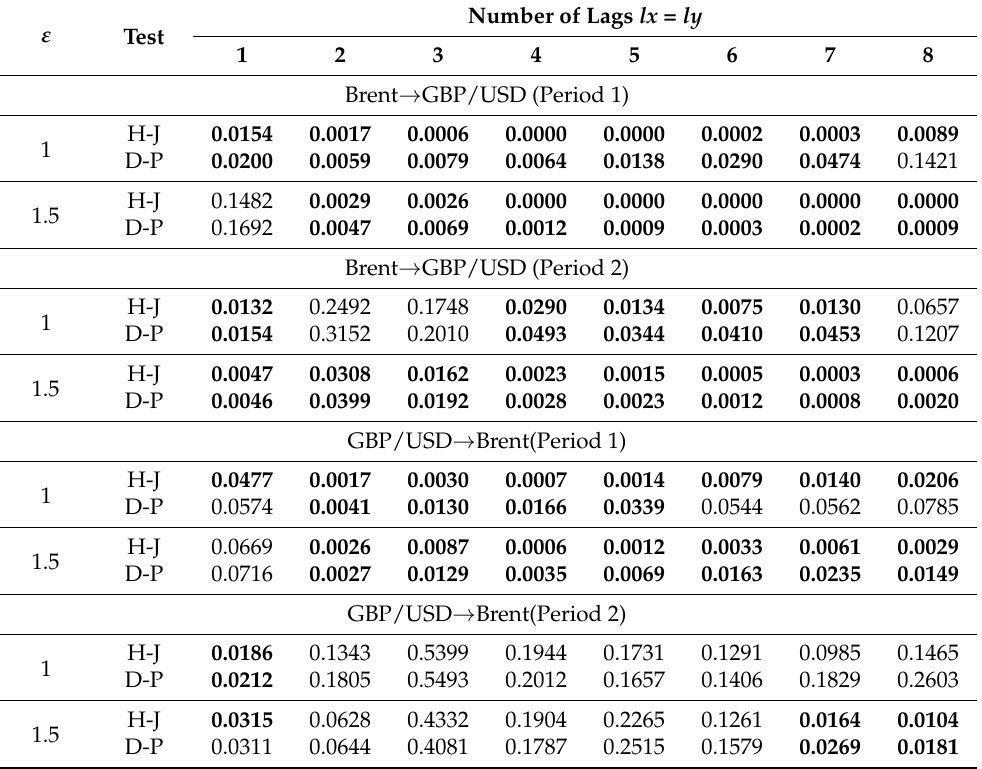
Table 3. Results of nonlinear Granger causality testing for crude oil and